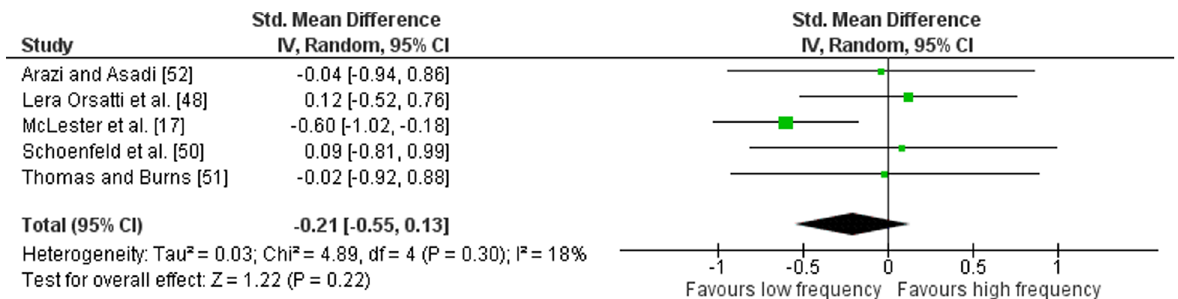
Fig. 12 Low vs. high weekly training frequency. Pre- vs. post-mean ES strength difference on lower body exercise. The vertical line indicates the overall estimate of combined multi-joint and isolation studies pre- vs. post-mean ES strength difference. Horizontal lines indicate 95% CI, squares estimates, whereas square size is proportional to sample size, and rhombs ’ meta-analytically pooled estimates